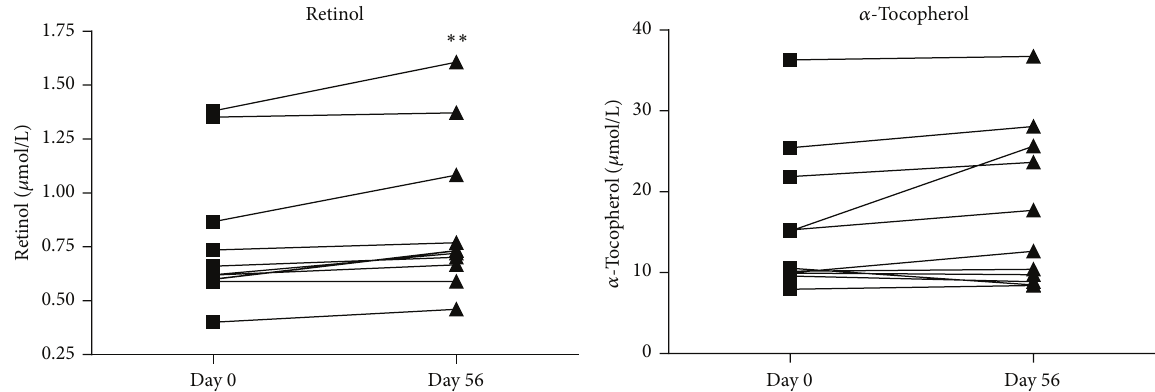
Figure 2: Plasma concentrations of retinol and 𝛼 -tocopherol at baseline and after RPO supplementation. Values are given in 𝜇 mol/L. Concentration of retinol was significantly increased (day 56) when compared with baseline (day 0) ( ∗∗ 𝑃 < 0.001 ). Concentration of 𝛼 - tocopherol remained unchained compared with